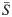
Output results from the runtsir function for London.Subplots A) and B) are the cumulative births against cumulative cases regression and estimated reporting rate, the C) and D) are the profiled S¯ from Zt and then reconstructed S, E) is 26-point βt with the α and mean β (indicated as β¯) estimate, and F) and G) are the data (blue) against 10 randomly chosen stochastic simulations (red) and the (inverse) data against mean of the simulations with confidence intervals.